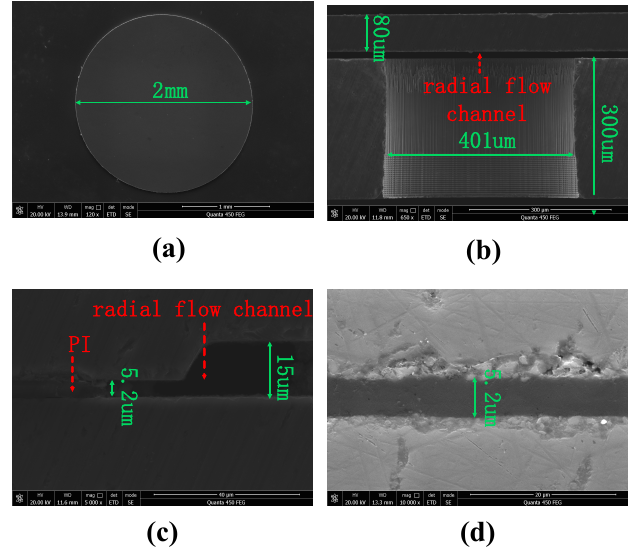
Figure 5. SEM images of different parts of the micro valve. ( a ) Top view of the valve plate. ( b ) The valve membrane and the outlet. ( c ) The radial flow channel. ( d ) The PI bonding interface. It is worth mentioning that PI is employed as the adhesion layer between two wafers. For the bonding process, the recommended heating condition is 50 °C to 100 °C higher than the glass transition temperature (Tg) of the PI layer [18,19]. As the Tg of the PI layer used is around 300 °C, the bonding temperature was set to 375 °C. Bonding pressure is